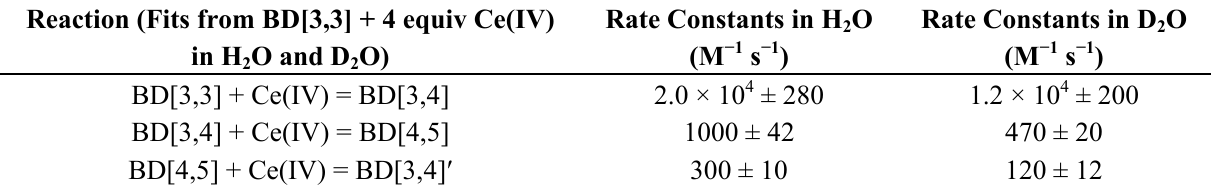
Table 2. Rate constants derived from kinetic modeling of the reaction of 0.1 mM BD[3,3] with 4 equiv of Ce(IV) in HNO kinetics fits are shown in Figures 3A and 4.